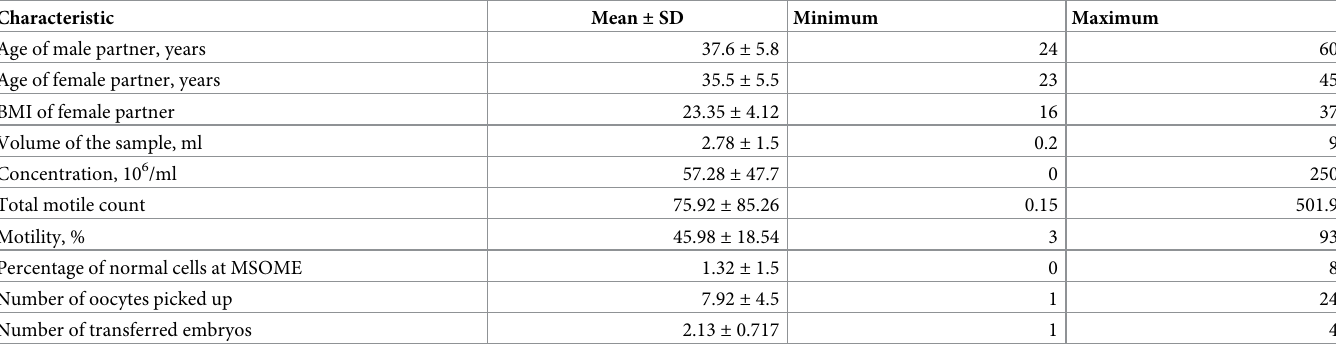
Table 1. Basic characteristics of the cohort.